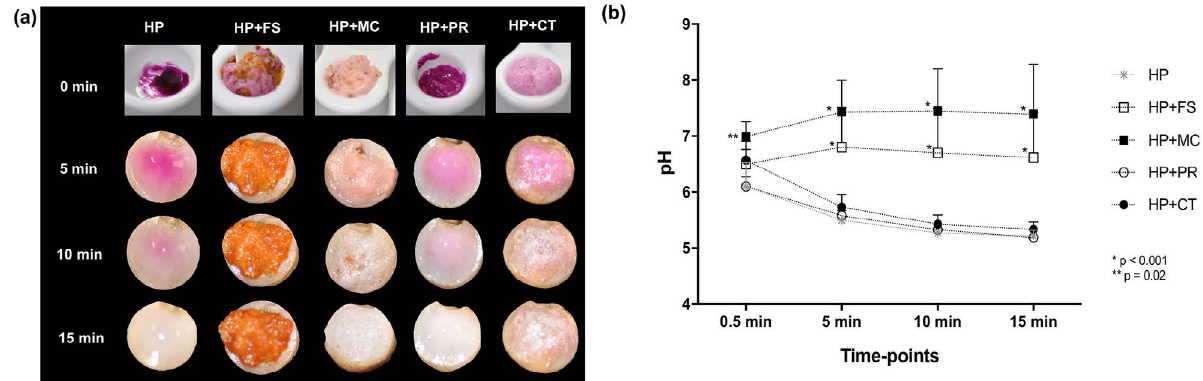
Figure 1- (a) Representative digital images of bleaching gel reaction in the presence or not of chemical activators, immediately after manipulation (0 min) and after 5, 10, and 15 min on enamel/dentin discs. Note the bubbles in HP+FS, HP+MC, and HP+CT groups. Deposition of brown sub-products can be observed in groups HP+FS and HP+MC. (b) Graph representative of mean (standard deviation) values of pH for the bleaching gels at 0.5, 5, 10, and 15 min. Asterisks indicates significant difference with the HP group (repeated measures Two-way ANOVA/Dunnet’s test, p<0.05)